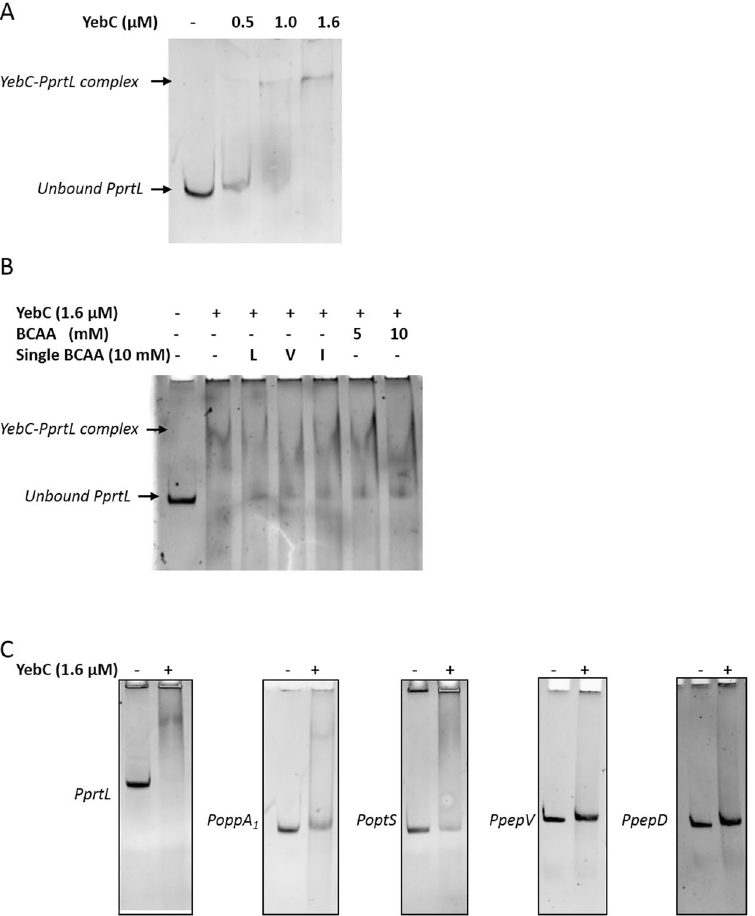
Figure 3. Electrophoresis gel mobility shift assay (EMSA) for YebC binding to different gene promoter regions. ( A ) EMSA assays performed using increasing concentrations of the purified H6-YebC (0, 0.5, 1.0 and 1.6 µ M) and 50 ng of DNA corresponding to the prtL promoter region ( PprtL ). ( B ) Effect of BCAA on YebC DNA binding to prtL promoter region. A DNA fragment containing the prtL promoter region ( PprtL lane 1) was incubated with 1.6 µ M of purified H6-YebC in the absence (lane 2) or presence of 10 mM of leucine (L, lane 3), valine (V, lane 4), isoleucine (I, lane 5), 5 mM (lane 6) and 10 mM (lane 7) of each BCAA. ( C ) Binding of YebC to selected promoter regions. 50 ng of target DNA containing the promoter region of prtL ( PprtL ), opts ( PoptS ), oppA 1 ( PoppA 1 ), pepD ( PpepD ) and pepV ( PpepV ) were incubated with 1.6 µ M of